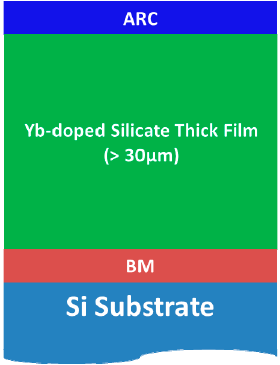
Figure 14. Schematic structure of the active disks prepared.